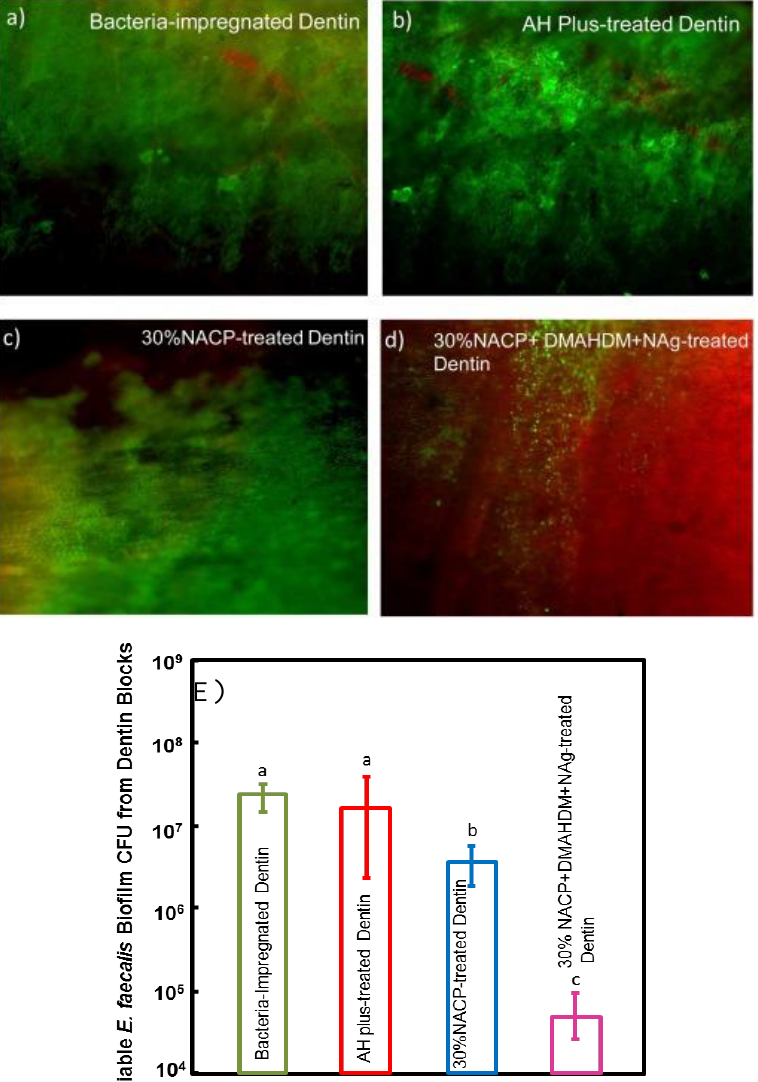
Figure 5. ( A – D ) Live / dead staining images of biofilms in dentin blocks. Live bacteria were stained green. Dead bacteria were stained red. Yellow / orange colors represent live and dead bacteria on top